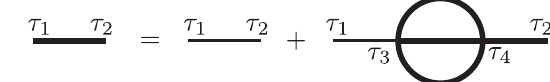
FIG. 5. Schwinger-Dyson equation for the full two-point function G ð τ 12 Þ